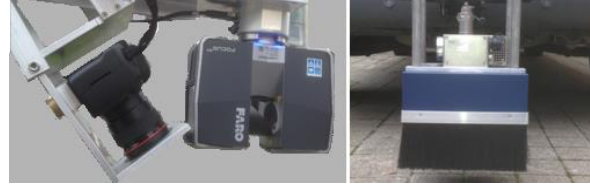
Figure 2. Canon camera, FARO laser scanner and Polytec spectrometer